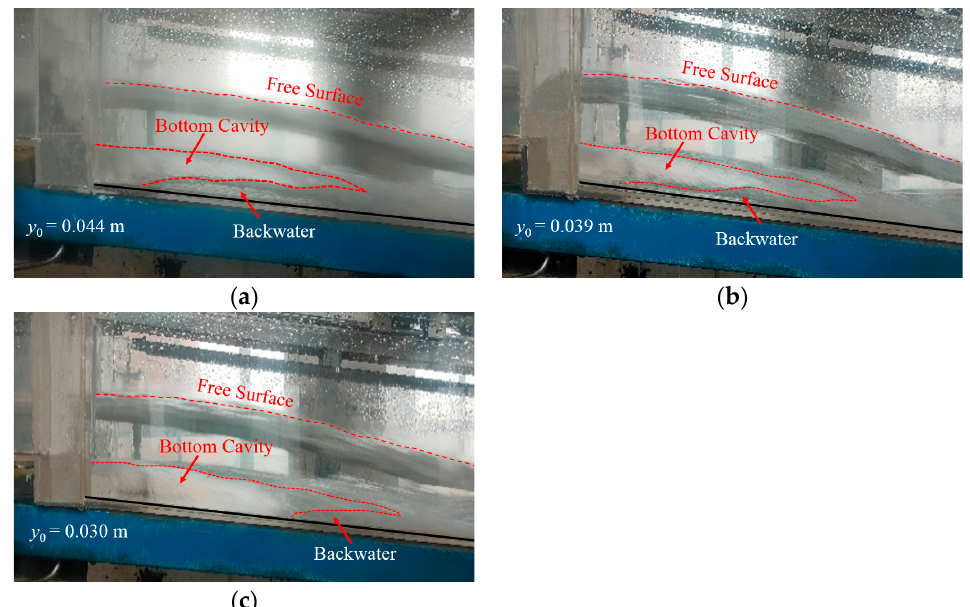
Figure 4. The backwater at different atmospheric pressure. ( a ) P a = 96 kPa; ( b ) P a = 56 kPa; ( c ) P a = 6 kPa.